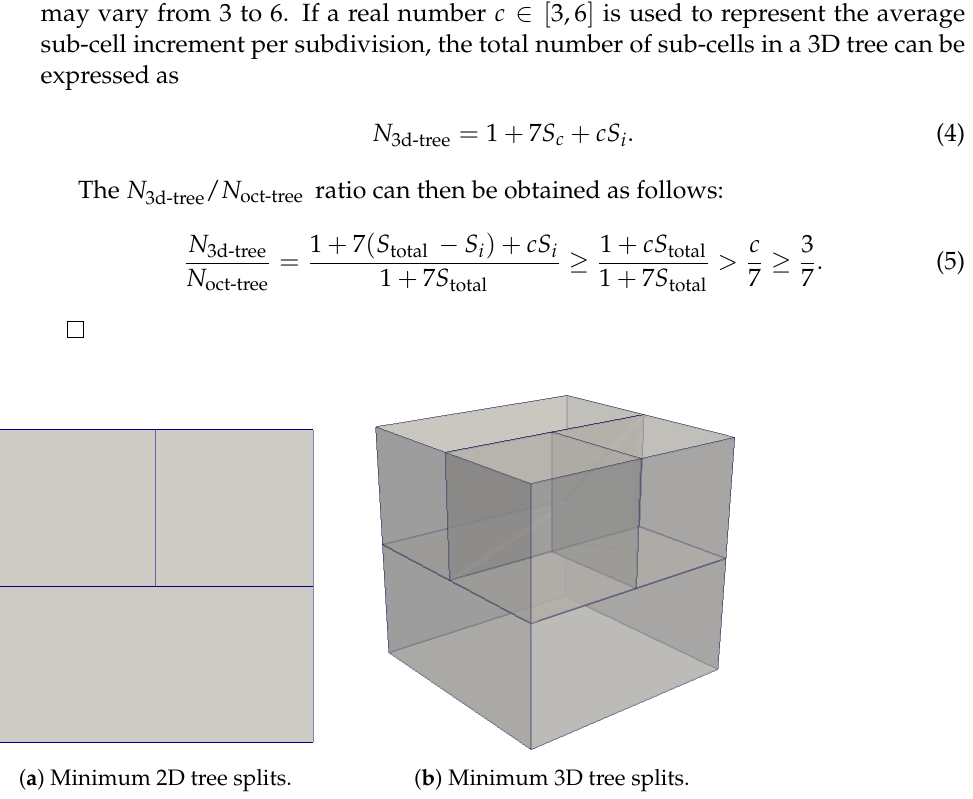
Figure 4. Minimum kd-tree splits within a single level: ( a ) 2D tree and ( b ) 3D tree splits, producing three and four sub-cells,